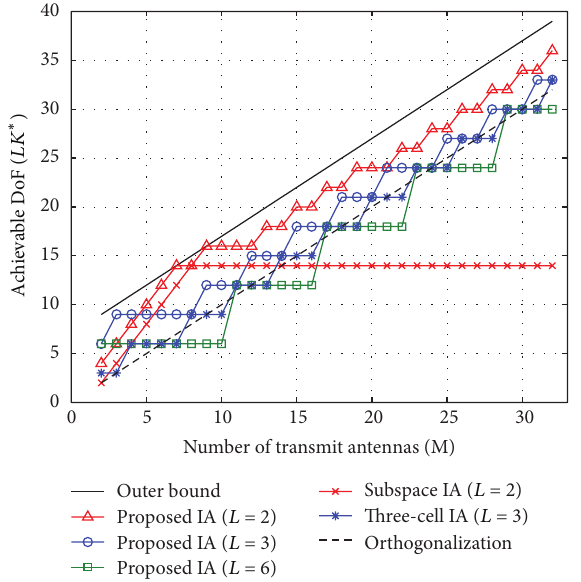
Figure 4: Achievable DoF versus number of transmit antennas when 𝑁 = 8 .